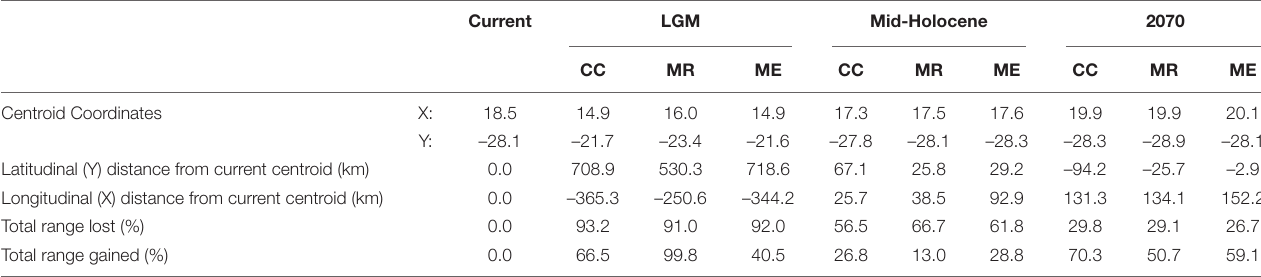
TABLE 3 | Aloidendron dichotomum latitudinal range shift values for the Last Glacial Maximum (LGM), mid-Holocene, and 2070, in relation to the current range.